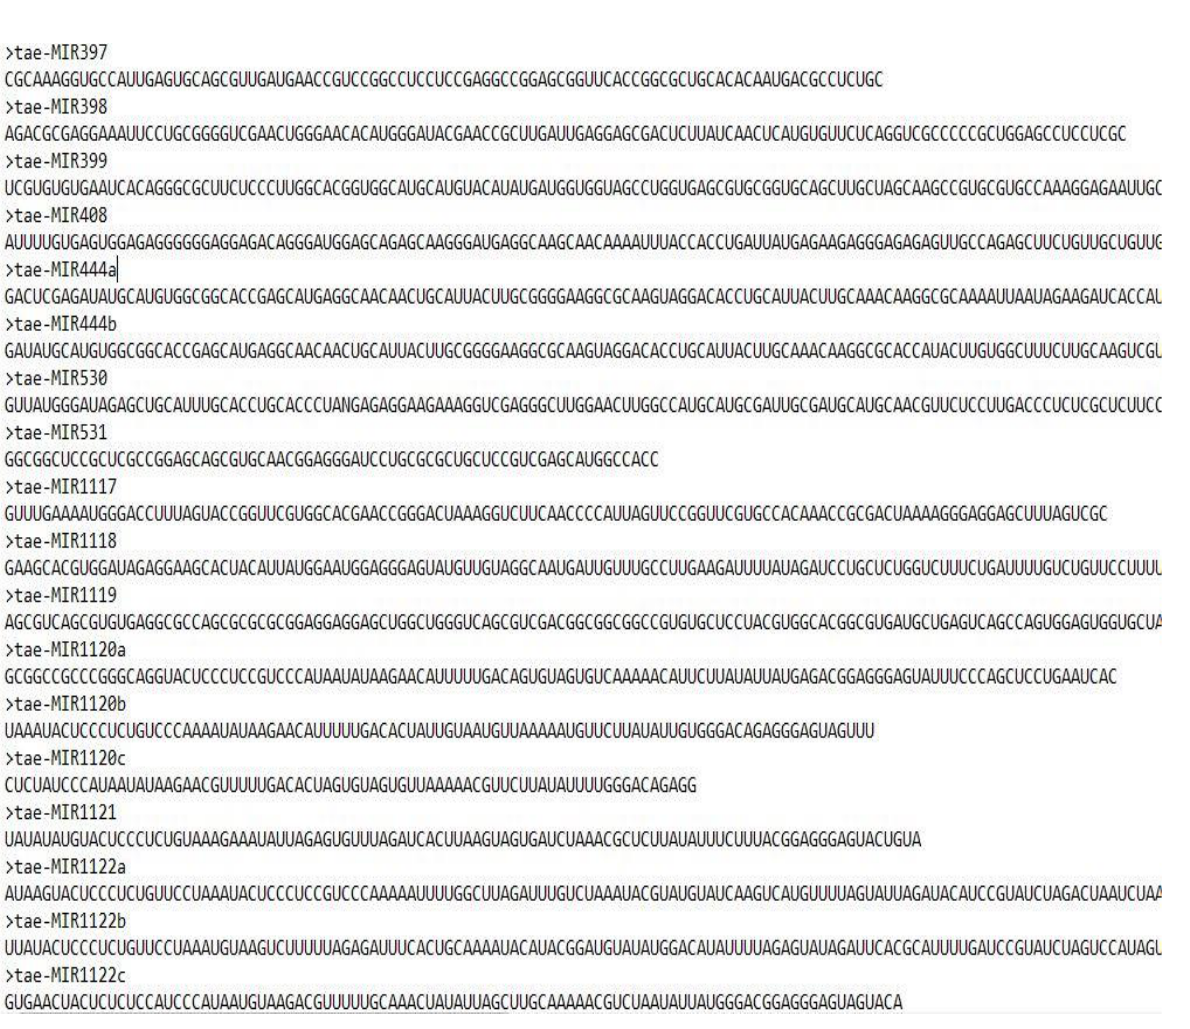
Figure 4. Sample of the dataset used in the experiments.